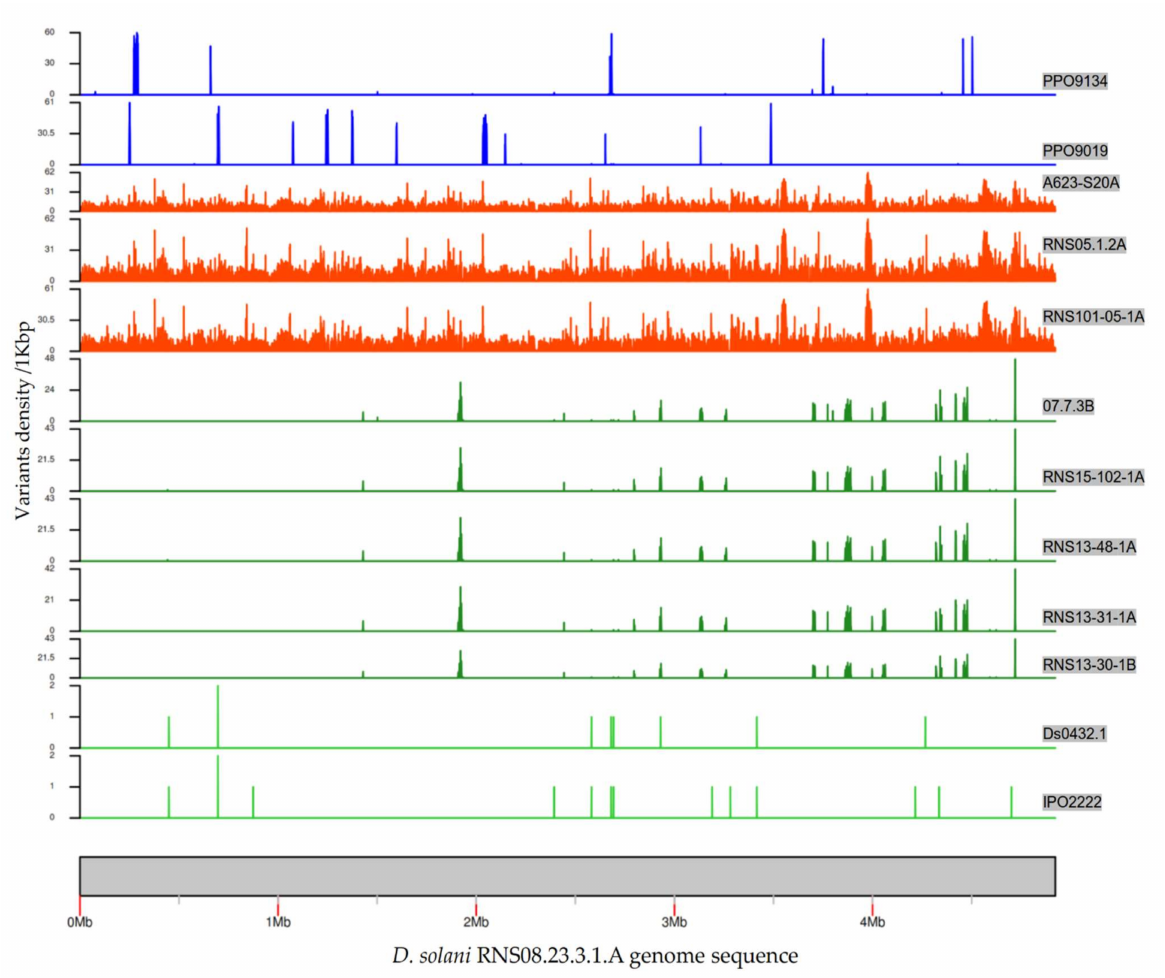
Figure 4. Graphical representation of the densities of variants in each D. solani strain. The D. solani RNS 08.23.3.1A genome was used as a reference. The densities were calculated based on a window size of 1 kbp. Scale of variants’ density/kbp was automatically adjusted, hence was not the same in each